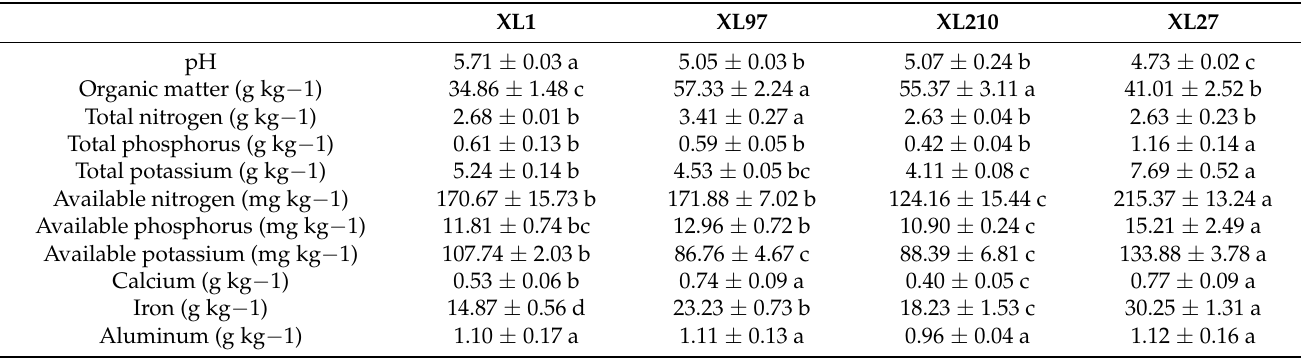
Table 2. Rhizosphere soil properties across different C. oleifera trees. Values are the means ± standard deviation ( n = 3). Different letters within a row indicate significant differences at a level of p < 0.05 between clone types (ANOVA followed by Fisher’s LSD test).